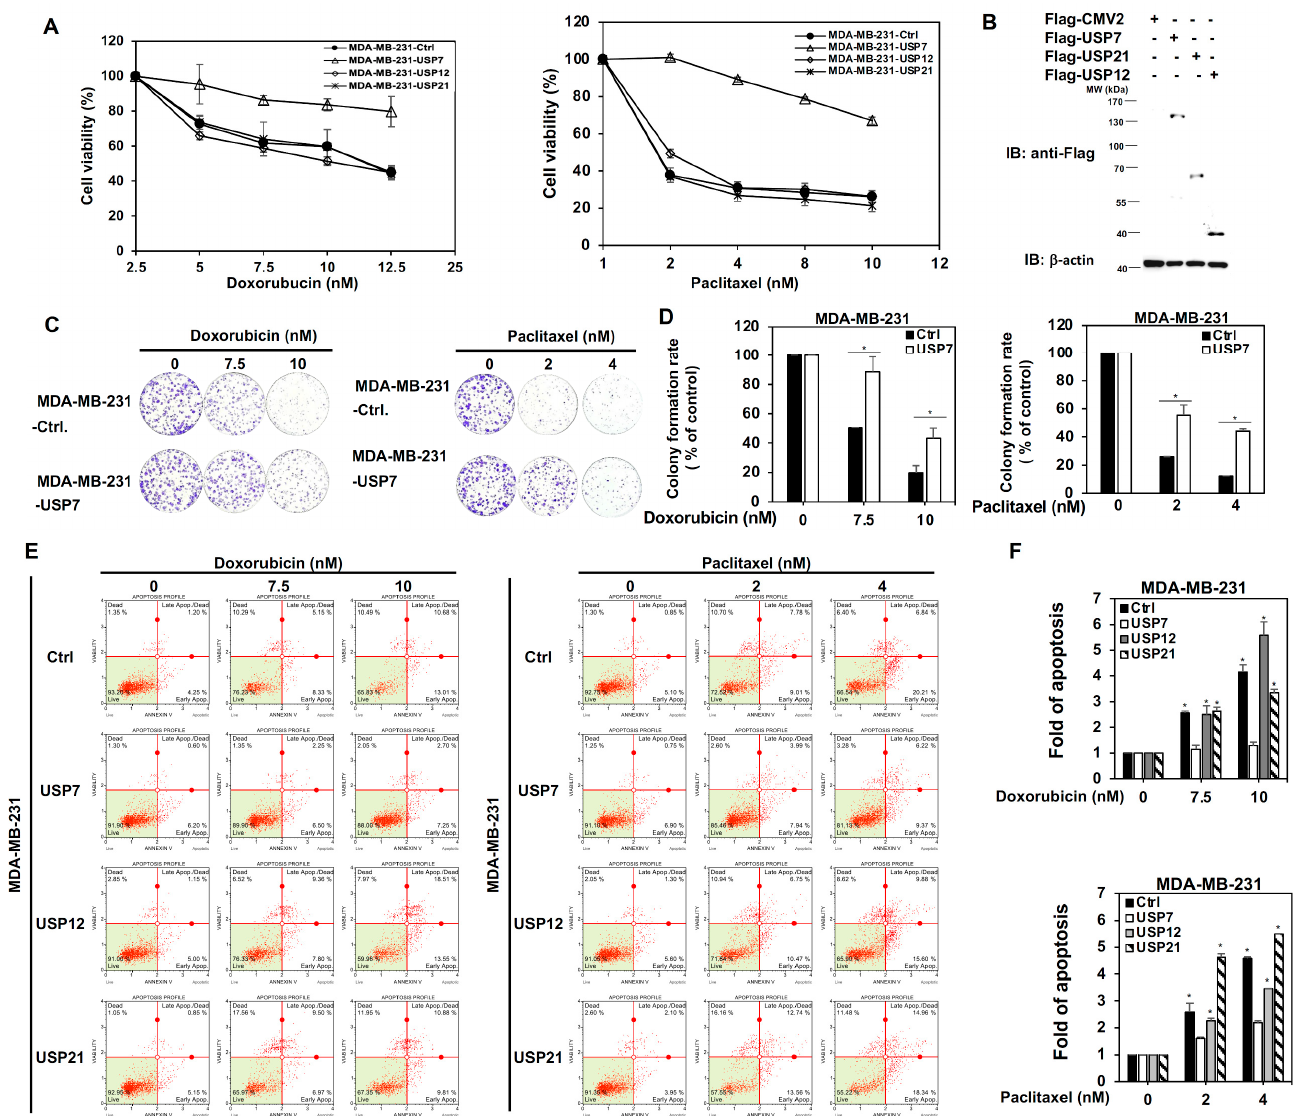
Figure 1. Role of ubiquitin specific protease (USP) 7 on the acquired chemoresistance of triple-negative breast cancer (TNBC). ( A ) Analysis of the viability of MDA-MB-231 cells with transient expression of USP7, USP12, and USP21, respectively, under serial doses of doxorubicin (left panel) or paclitaxel (right panel) treatment, as assed using MTT assays. ( B ) Protein levels of USP7, USP12, and USP21 in MDA-MB-231 cells with transient expression of USP7, USP12, and USP21, respectively, as assessed using western blot analysis. ( C ) Analysis of growth ability of MDA-MB-231 cells with transient expression of USP7 treated with doxorubicin (left panel) or paclitaxel (right panel) using colony formation assays. ( D ) Quantitative analysis of colony formation assays for doxorubicin (left panel) or paclitaxel (right panel)-treated MDA-MB-231-USP7 cells. ( E ) Analysis of apoptosis in MDA-MB-231 with transient expression of USP7, USP12, and USP21, respectively, treated with doxorubicin (left panel) or paclitaxel (right panel) according to Annexin V-dependent flow cytometry assays. ( F ) Quantitative analysis of the apoptotic levels of two different doses of doxorubicin (upper panel)- or paclitaxel (lower panel)-treated MDA-MB-231 cells with transient expression of USP7, USP12, or USP21, respectively. Data are represented as the mean ± SEM for biological triplicate experiments. * p < 0.05, compared with the results for control cells.